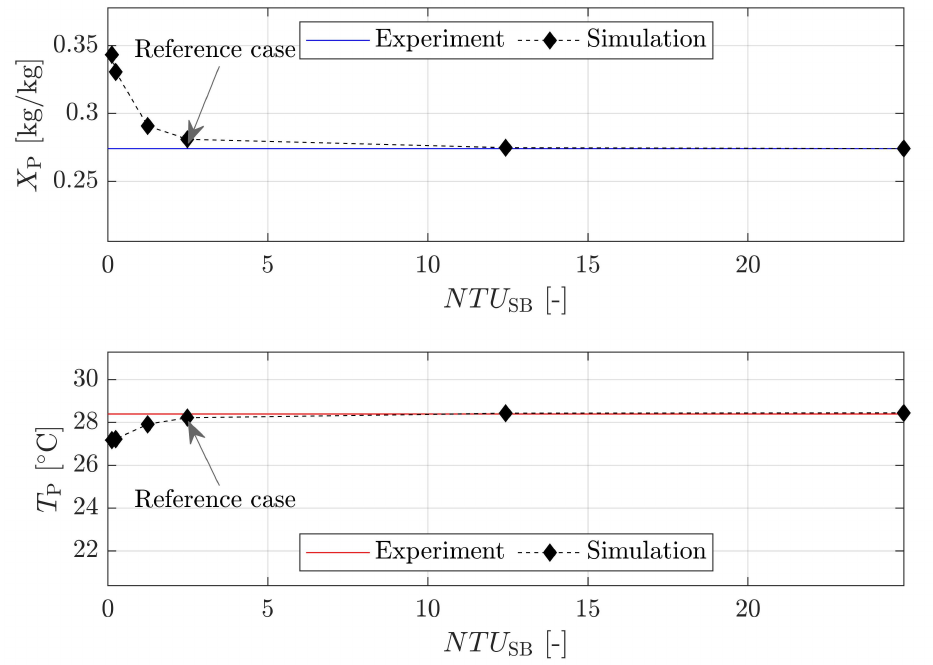
Figure 18. Sensitivity analysis of model predictions regarding the number of transfer units between suspension and bubble phase. The impact on particle moisture content ( X P ) (top) and particle temperature ( T P ) (bottom) for reference case GF3_A_02 with γ -Al 2 O 3 particles in the GF3 lab-scale dryer is shown.